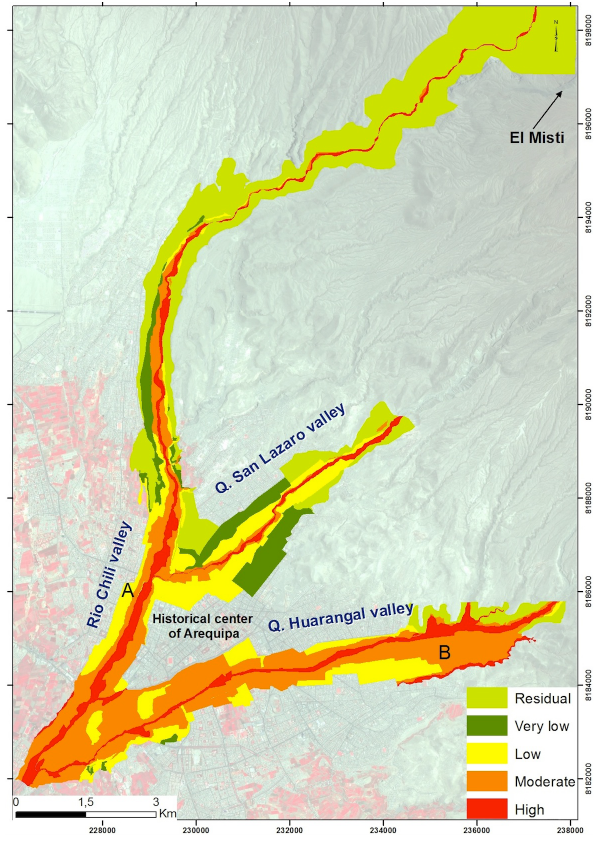
Fig. 5. Lahar-prone areas in the city of Arequipa. Hazard level (HL) includes five classes according to Table 3. Letters A and B refer to the places where pictures in Fig. 3 were